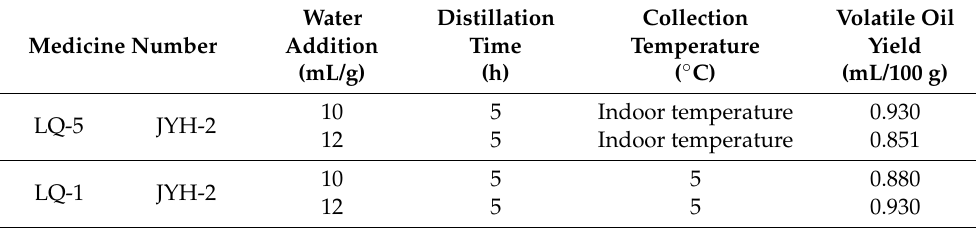
Table 7. Co-distillation of volatile oils from F. suspensa and L. japonica